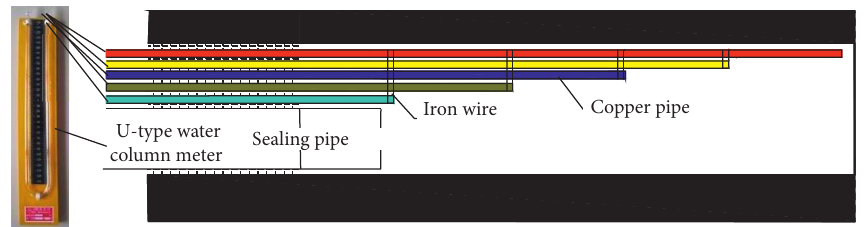
Figure 15: Schematic diagram about using bunch of pipes method to test negative pressure distribution.